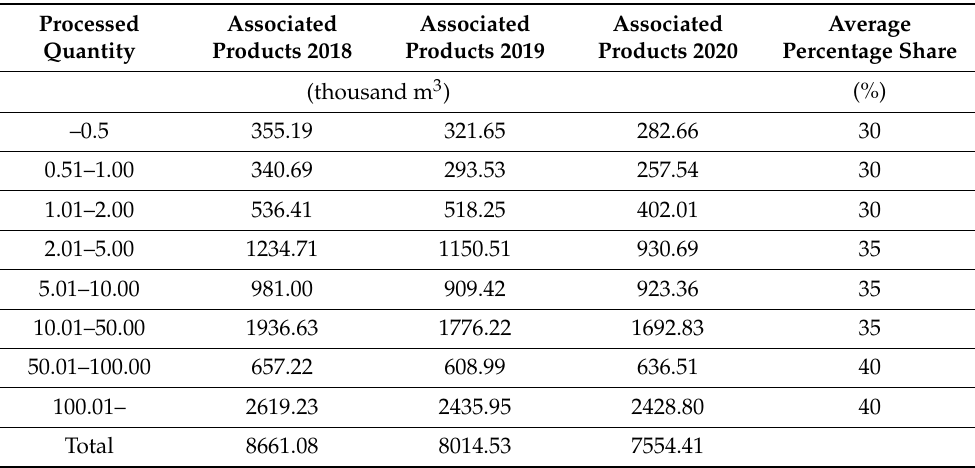
Table 5. The amount of biomass (by-product of processing) generated in sawmills, depending on the volume of wood